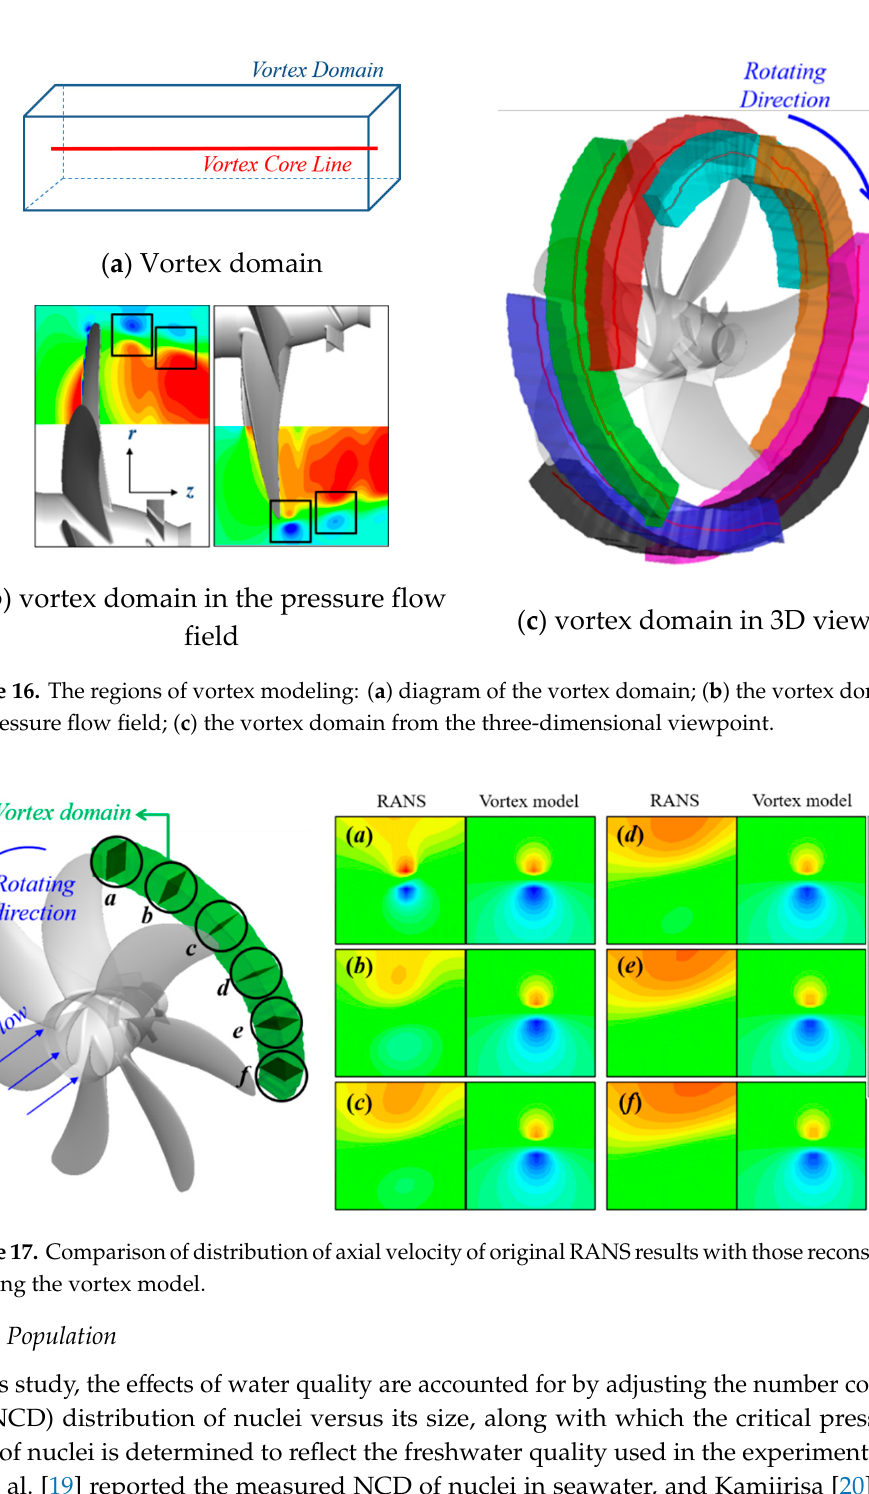
( b ) Figure 18. Domain for nuclei distribution in the flow field: ( a ) iso-metric view; ( b ) front-view